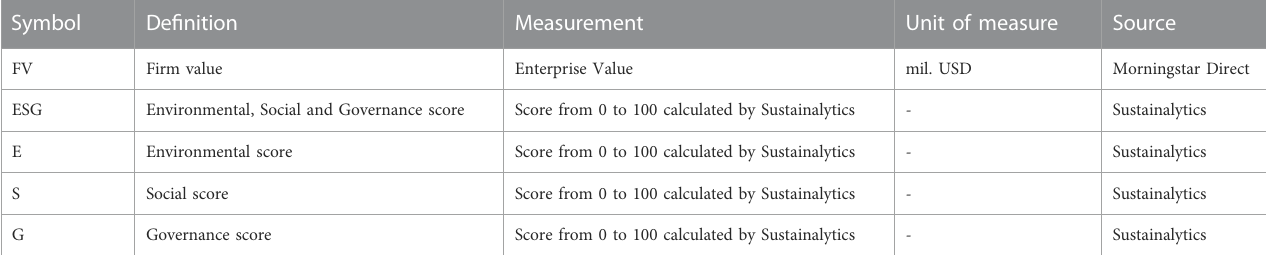
TABLE 2 Summary of variables used in the